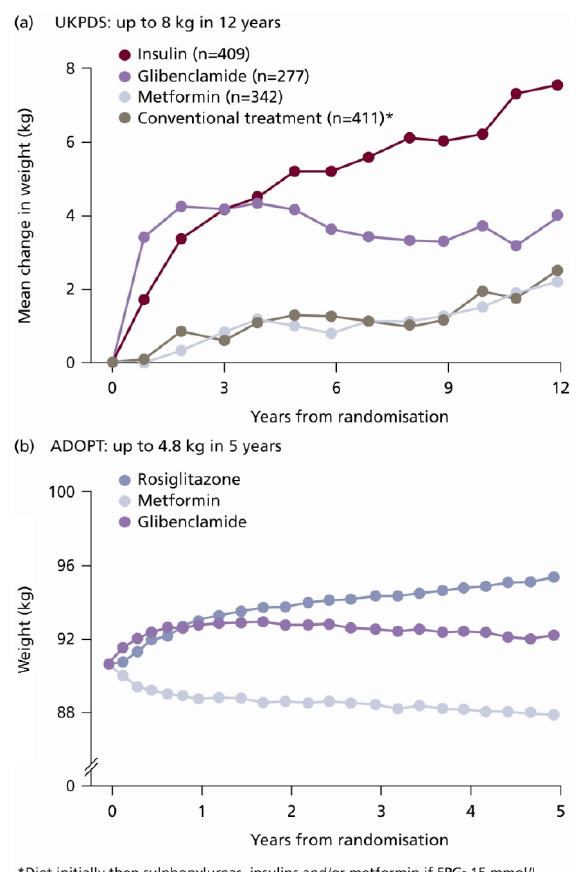
Figure 2. Weight change associated with each treatment group included in the (a) UKPDS and (b) ADOPT study [1,2]. Figure 2a reprinted from [1] with permission from Elsevier (© 1998); Figure 2b reprinted from with [2] permission from the Massachusetts Medical Society [2] (© 2006). All rights